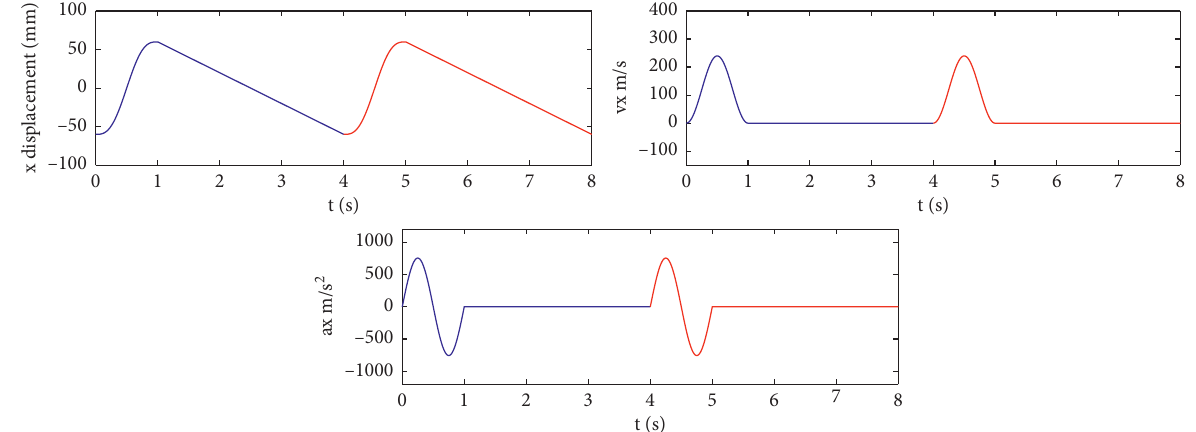
Figure 9: Foot displacement, velocity, and acceleration curves in x- direction.